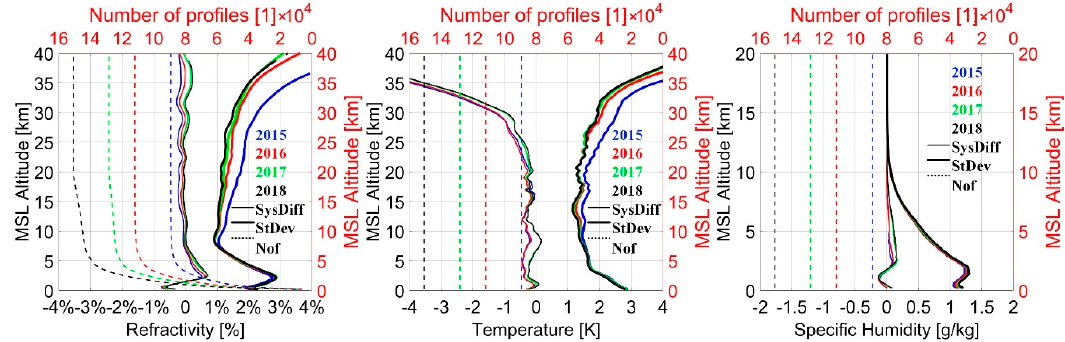
Figure 4. Global mean systematic differences (SysDiff, thin lines) and corresponding Standard deviation (StDev, thick lines) of FY-3C refractivity, temperature, and specific humidity profiles for the years from 2015 to 2018. Dashed lines indicate the number of profiles (Nof) used for the yearly statistics.